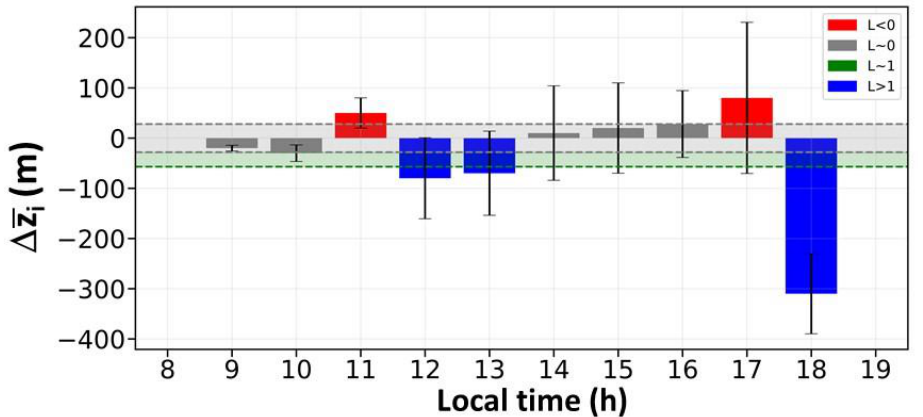
Figure 8. Diurnal evolution of z i ̅ and L. Gray and green horizontal bands represent the regions where L tends to 0 and 1, respectively.